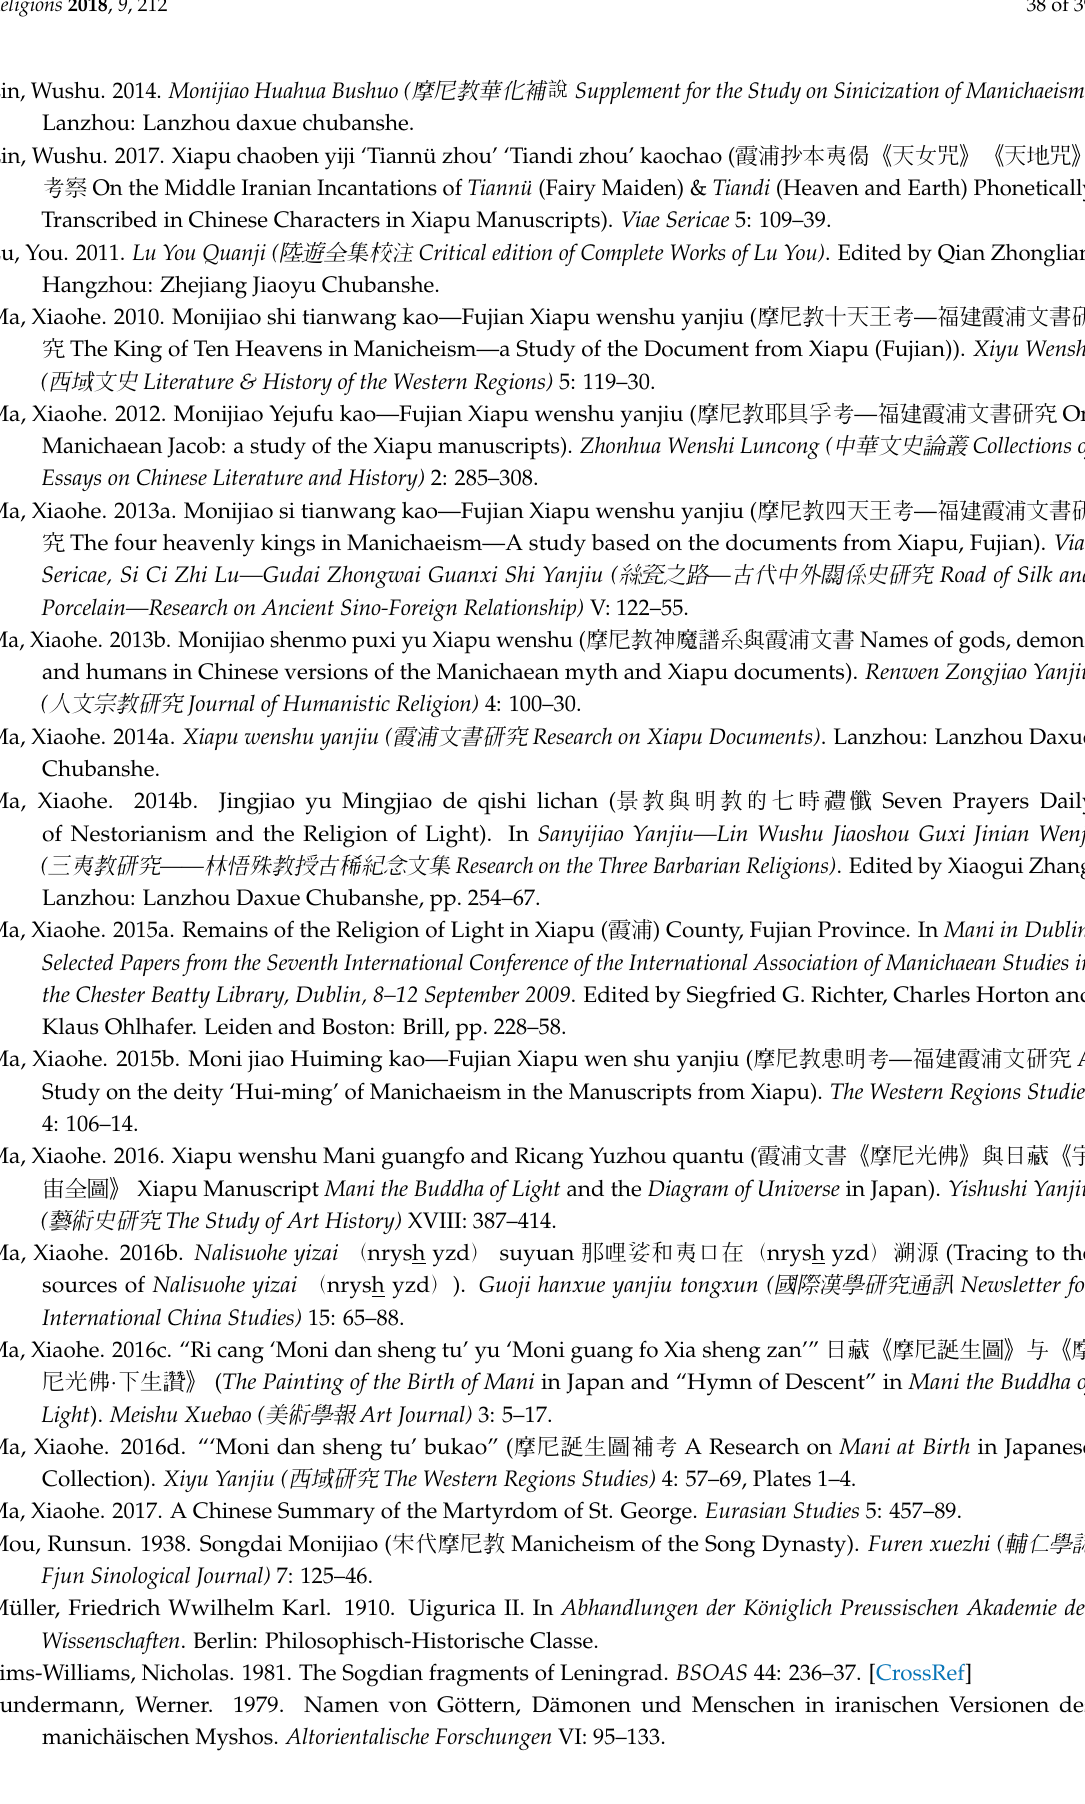
Figure 10. Four Great Venerable Buddhas (Gulácsi 2016, Figure 6/17 [p.